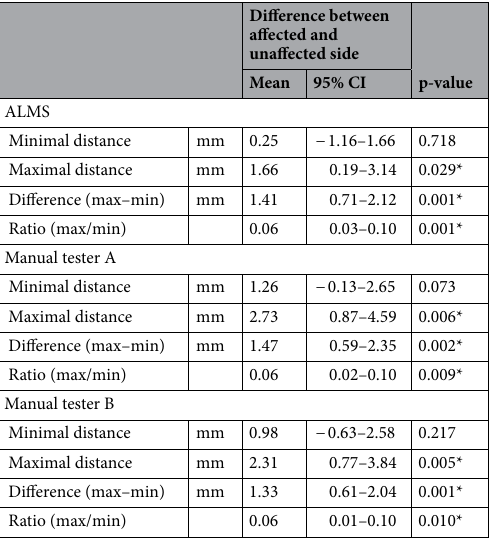
Table 5. Comparison of differences between affected and unaffected ankles in talofibular joint distance between the ATFLs during the reverse anterior drawer test. ATFL anterior talofibular ligament,